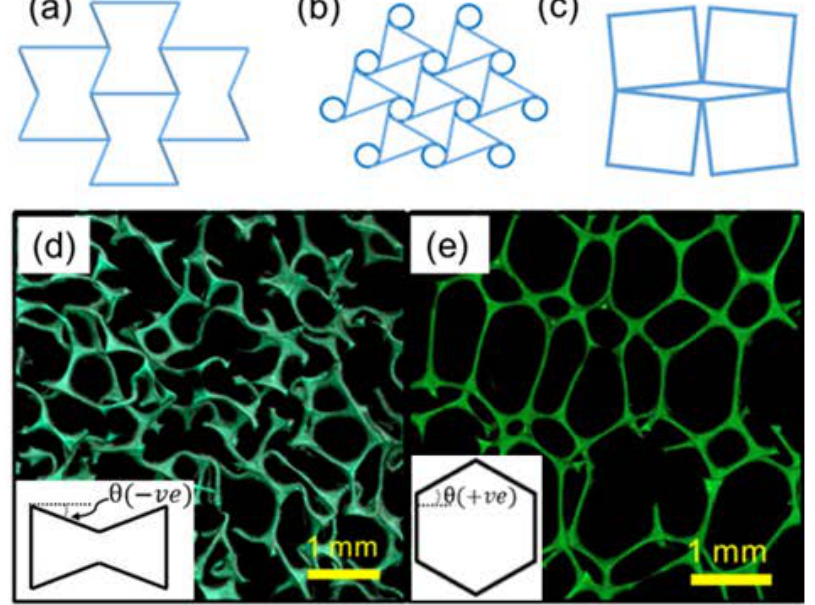
Figure 3. ( a ) Assembled 2D re-entrant structure; ( b ) 2D Chiral structure; ( c ) 2D rotating squares structure; ( d ) Micro Computed Tomography of polyurethane auxetic open cell foam (depth = 1 mm), pop-out showing simplified 2D diagram of a re-entrant cell, θ = re-entrant angle (negative value for angle below horizontal axes); ( e ) Micro CT scan of conventional open cell PU foam (depth = 1 mm), with pop-out showing simplified 2D diagram of a conventional polyhedral cell, θ = cell rib angle (positive value for angle above horizontal